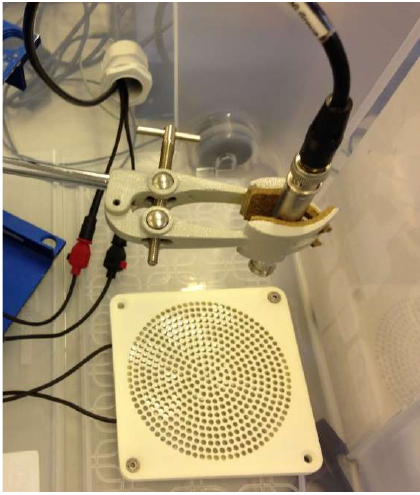
Figure 6. DEAP loudspeaker inside plastic box and the PCB 378B02 condenser microphone placed on top.